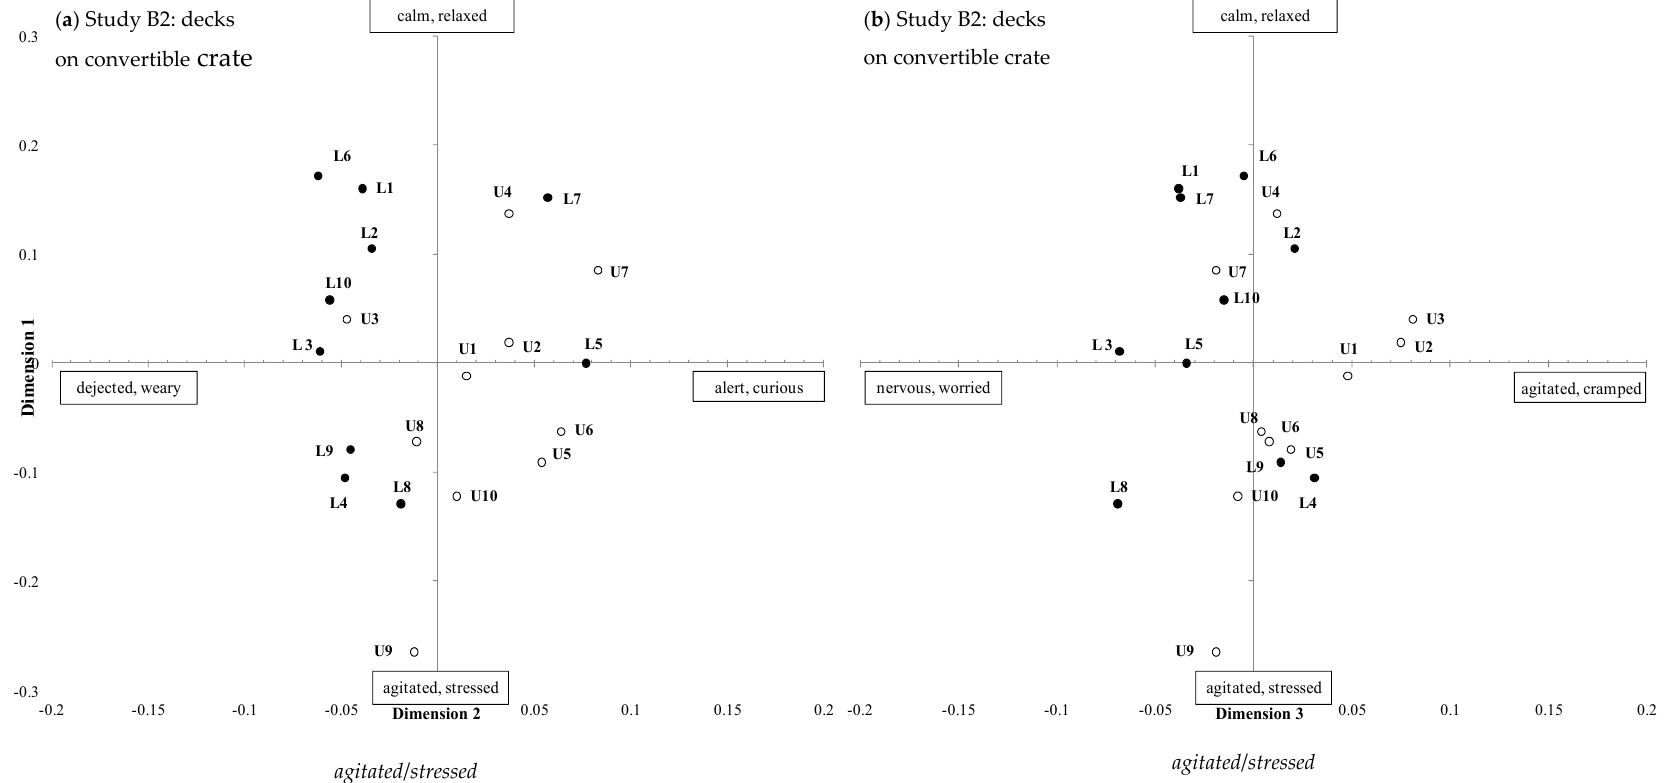
Figure 7. Positions of individual transport clips (numbers represent each transport trip) obtained from Qualitative Behavioural Assessment in Study B2 for convertible crate experiment (U: upper deck, open circles, or L: lower deck, closed circles) showing the same data plotted for ( a ) GPA dimensions 1 and 2 and ( b ) GPA dimensions 1 and 3.